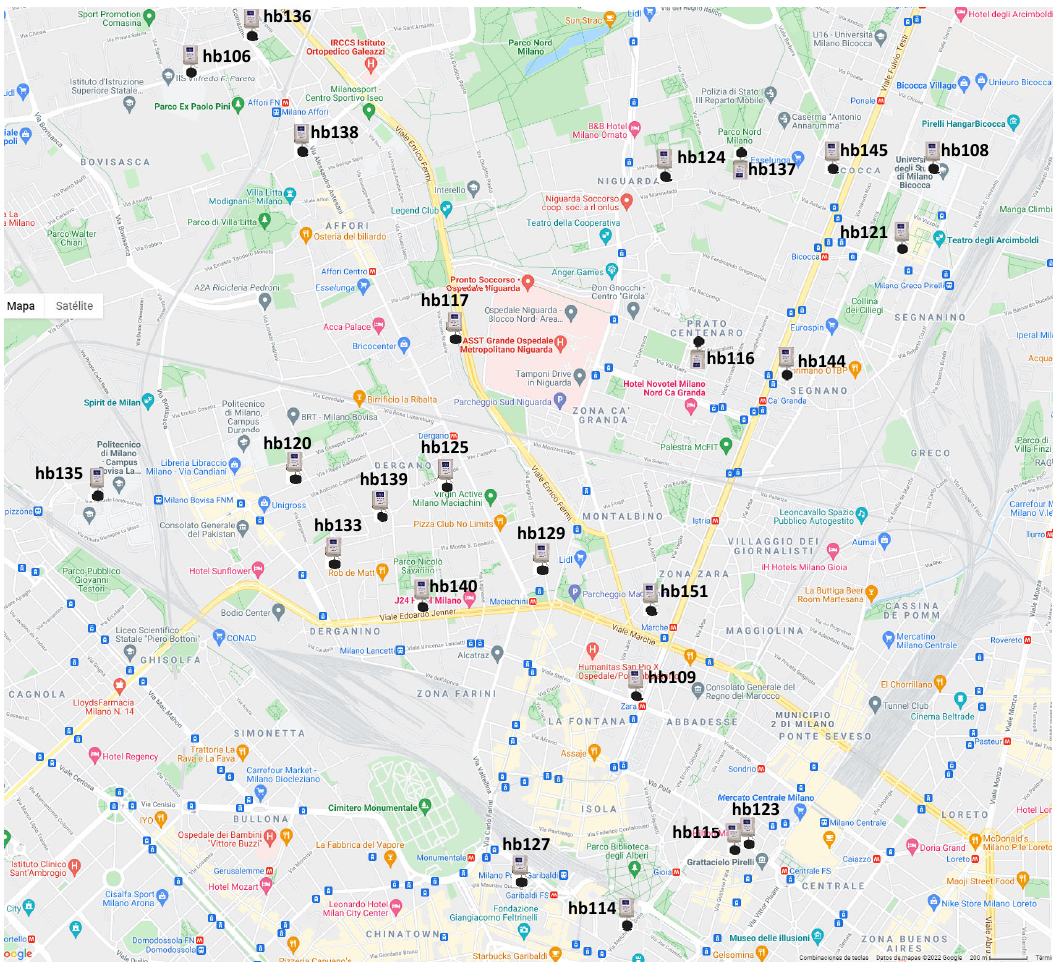
Figure 3. Map of the acoustic sensor locations of the WASN deployed across District 9 of Milan (urban environment), adapted from Google Maps ®